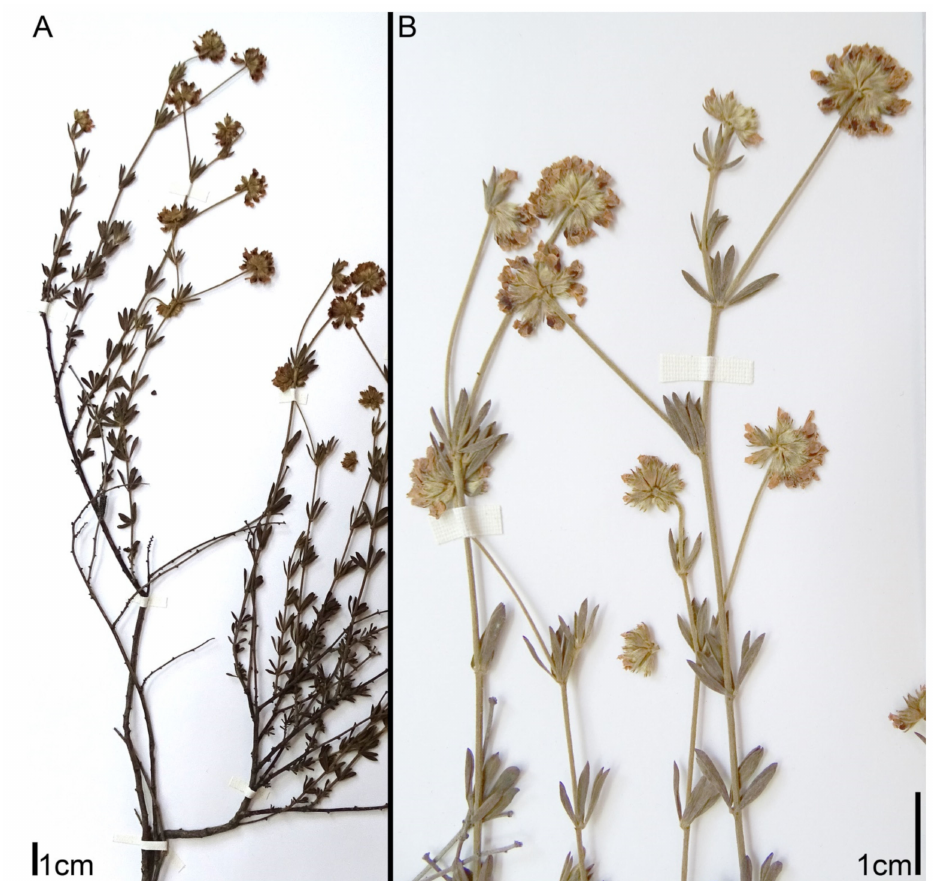
Figure 4. Morphology of Lotus dorycnium ssp. dorycnium . Herbarium specimen PENT03: Spain, E.Loriente s.n. (MA 658686): ( A ) habit; ( B ) fragments of flowering